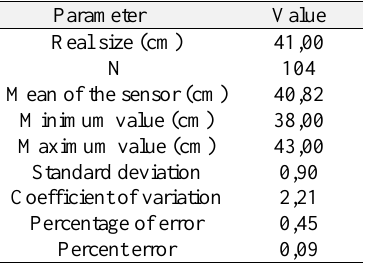
Table 4. Results obtained for the 41 cm water